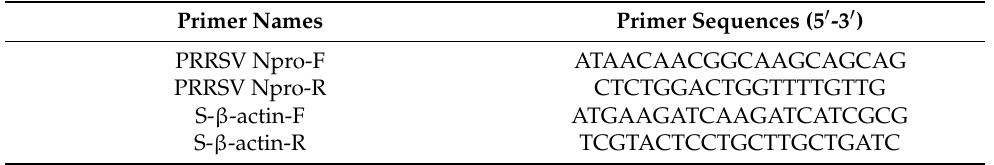
Table 4. Primers for RT-qPCR in this